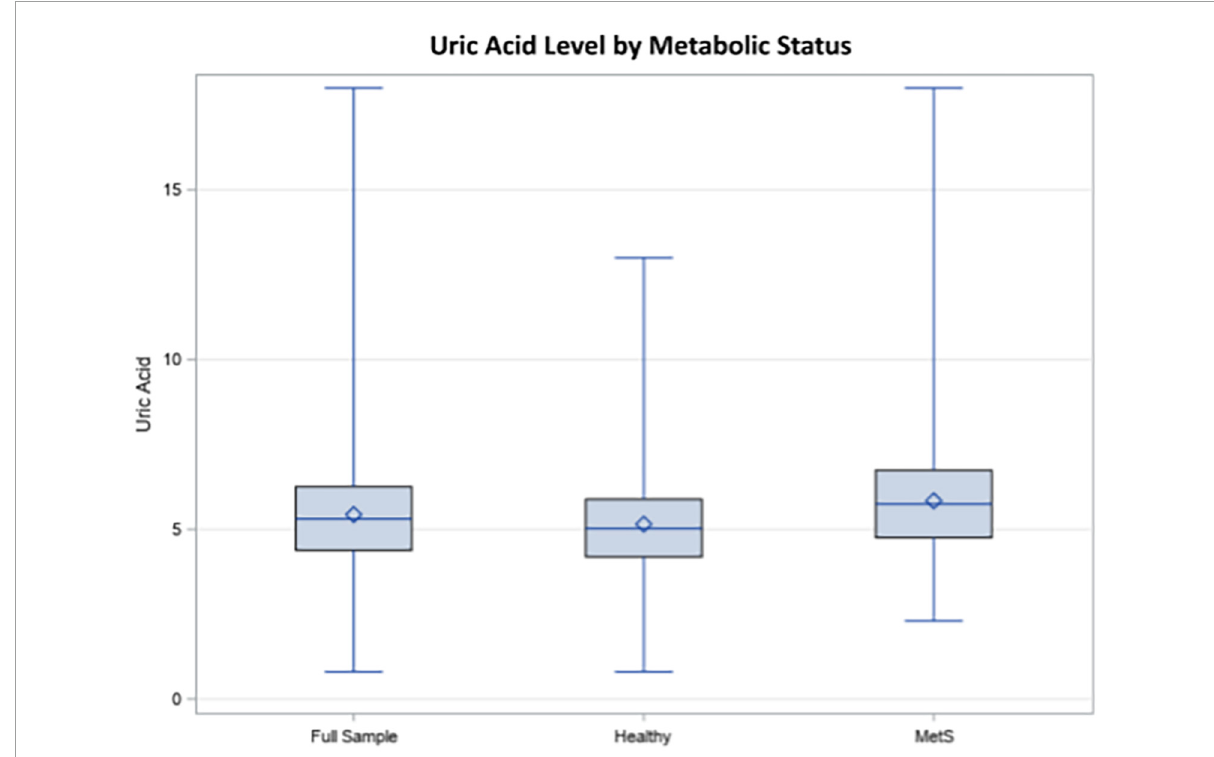
FIGURE1 Uric acid (UA) levels in the total sample, healthy individuals, and individuals with metabolic syndrome (MetS).